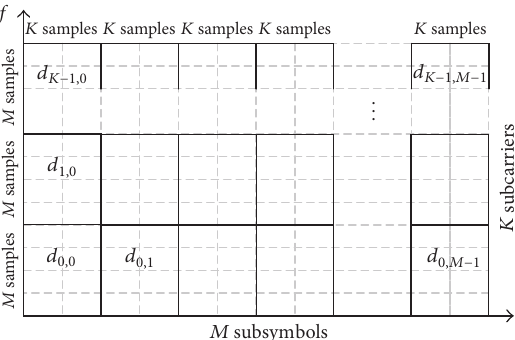
Figure 2: GFDM symbol mapping